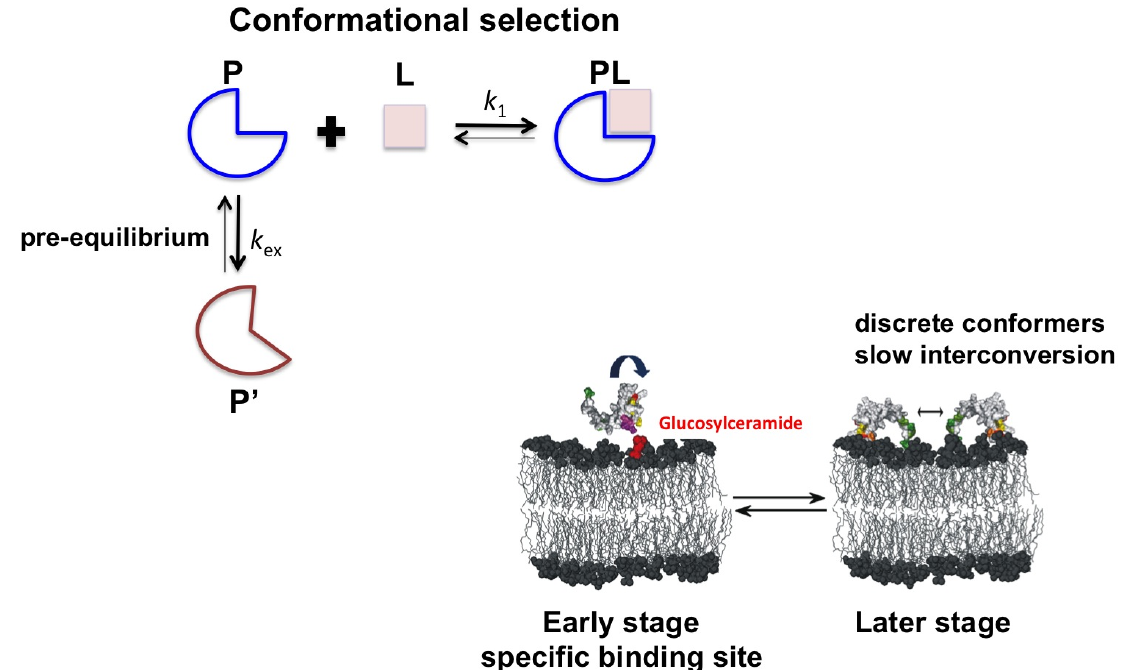
Figure 4. Proposed model for the Sd5 interaction surface with a membrane mimetic. In a conformational selection mechanism, the binding competent conformation (blue, P) preexistts in solution prior to the addition of the ligand (L). Residues affected by the interactions with PC:CMH vesicles are colored in purple (the specific binding site), and DPC micelles are colored in yellow and green (the nonspecific binding site). The component of the fungal membrane, glucosylceramide (CMH), is highlighted in